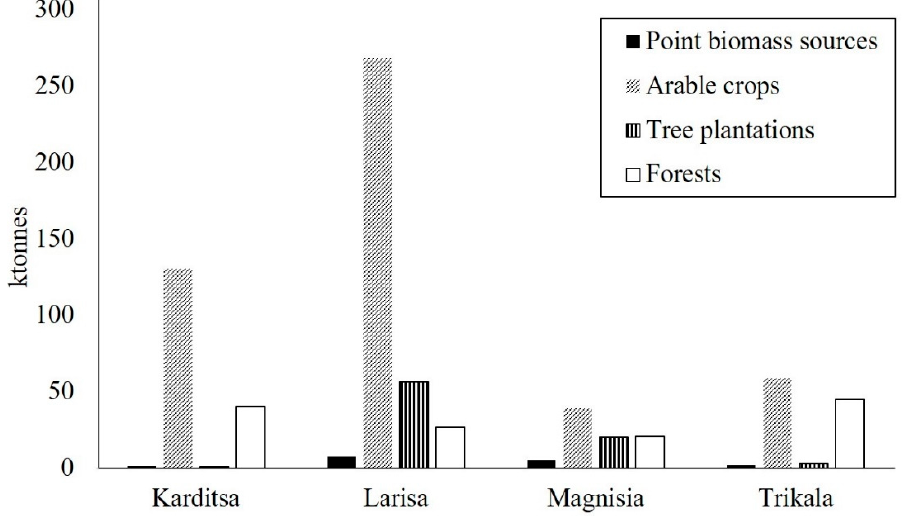
Figure 10. Biomass potential by source and Regional Unit of Thessaly (in ktonnes) [16,21,22].